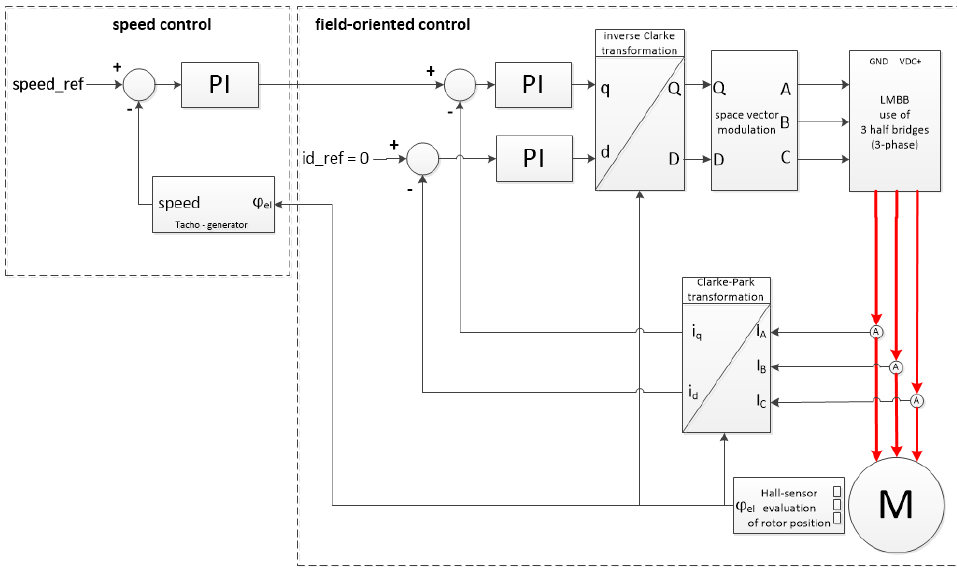
Figure 19. Scheme of the speed and field-oriented BLDC motor control.